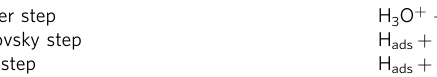
Table 1 Underlying electrochemical processes occurring during the H evolution reaction Volmer